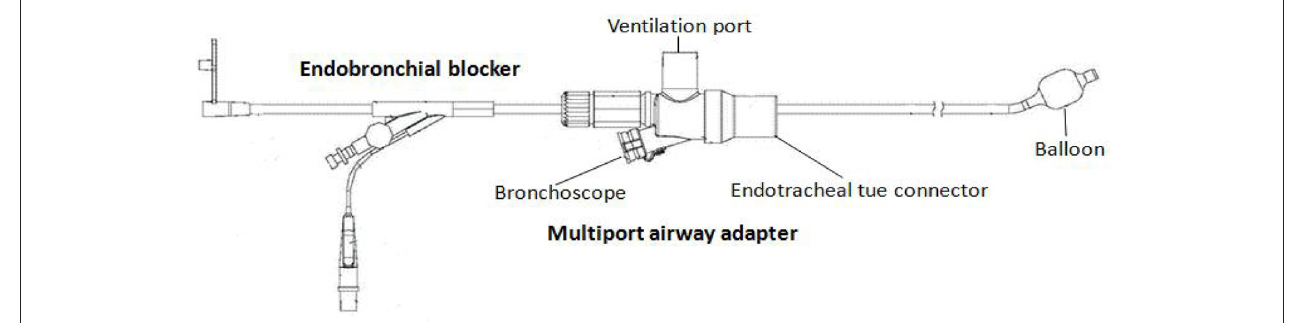
FIGURE 2 | The pediatric endobronchial blocker system.